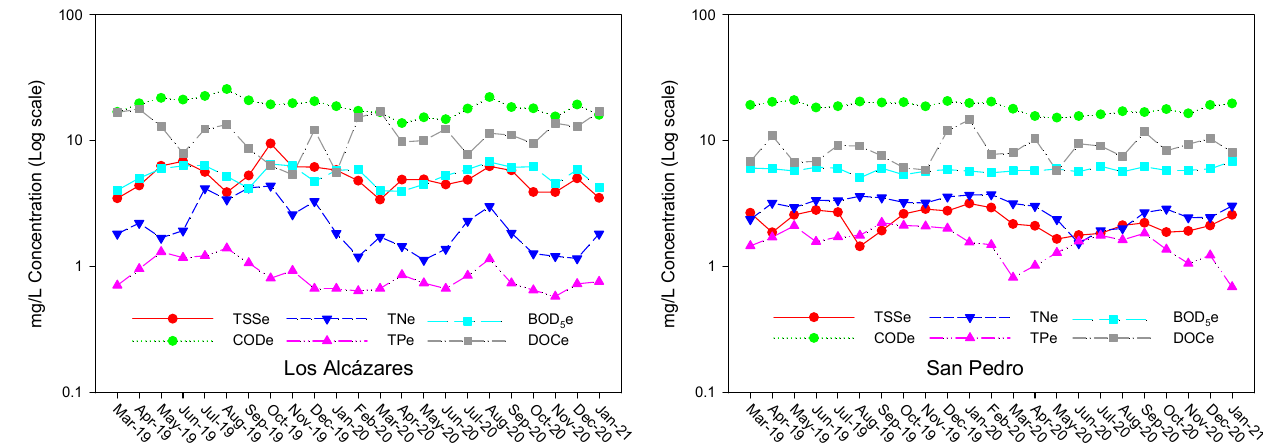
Figure 3. Temporal variation of average monthly effluent (e) parameters.